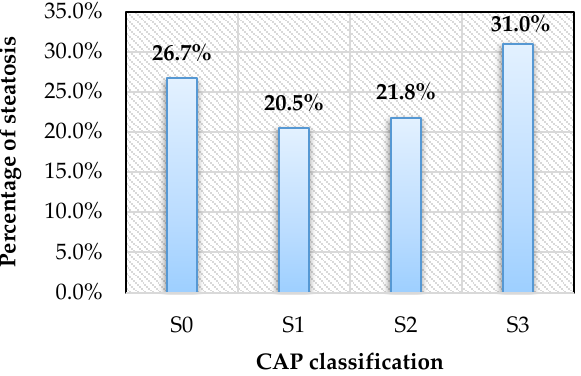
Figure 1. Hepatic steatosis on FibroScan with controlled attenuation parameter (CAP). S0, CAP ≤ 233 dB / m; S1, CAP 234–269 dB / m; S2, CAP 270–300 dB / m; S3, CAP ≥ 301 dB / m.